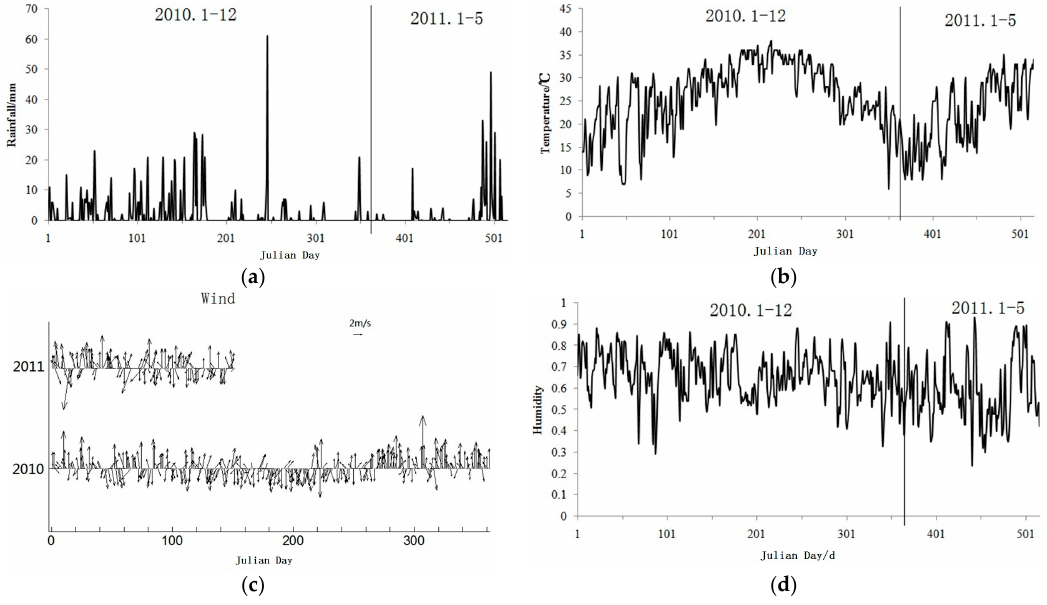
Figure 2. Time series of daily rainfall ( a ); temperature ( b ); winds ( c ); and humidity ( d ) from 1 January 2010 to 31 May 2011 nearby CTR (The base time for Julian date in all figures in this paper was 1 January 2010).